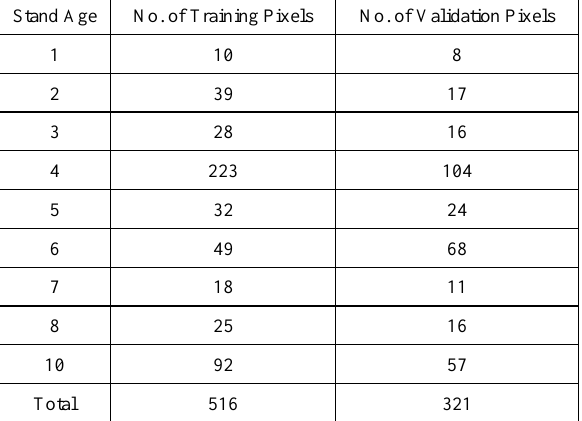
Table 1 . The sets of training and validation pixels for multivariate regression